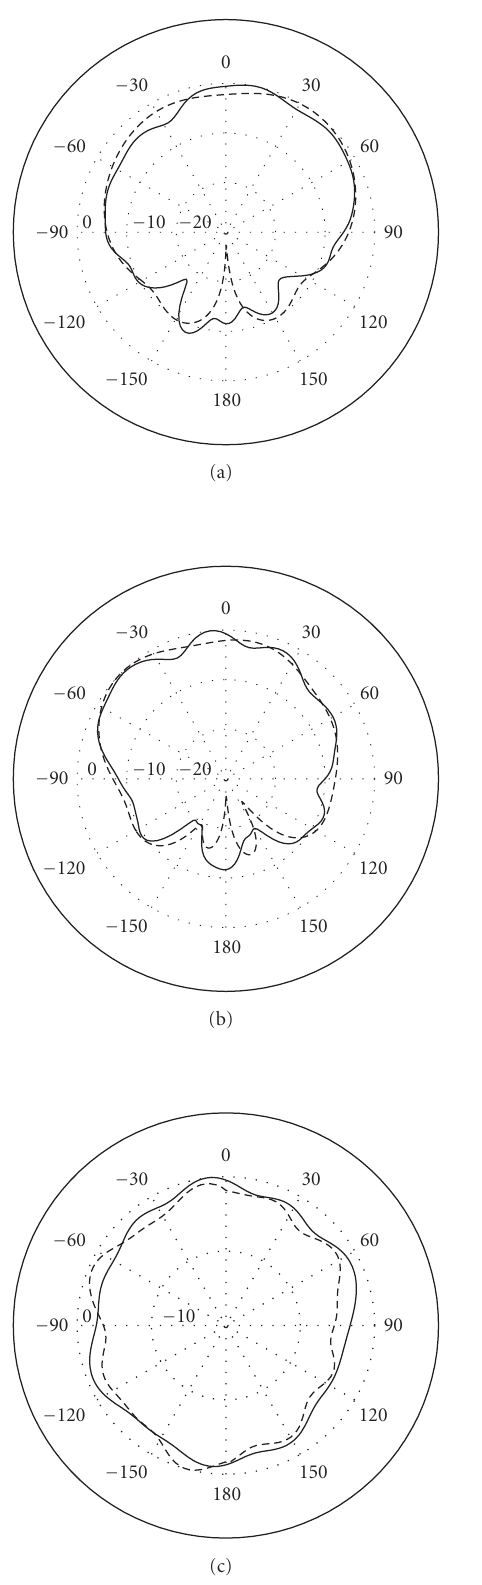
Figure 11: Measured (solid line) and simulated (dashed line) radiation patterns at 5GHz: (a) x - z plane, (b) y - z plane, and (c) x - y plane.